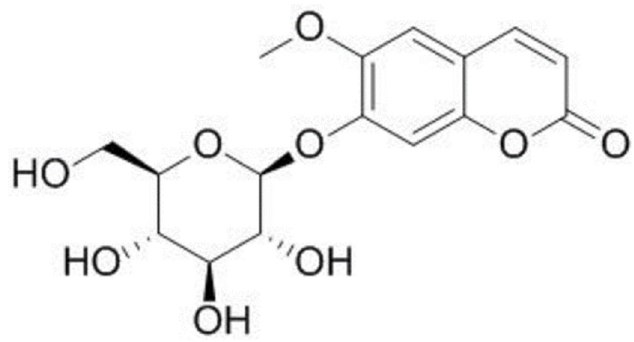
Figure 1. Chemical structure of scopolin.